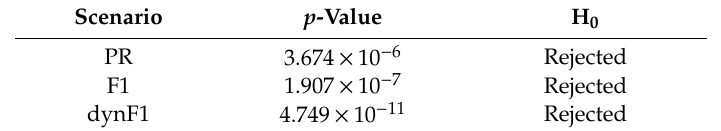
Table 6. Friedman test. Since p -value < 0.05 ( α ), each null-hypothesis is rejected.